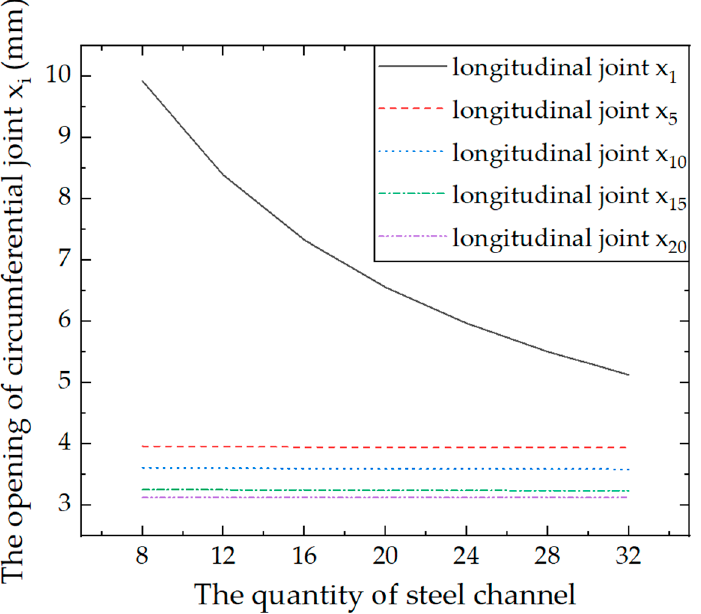
Figure 17. The relationship curve between the quantity of steel channels and the opening of circum- ferential joints for different rings.